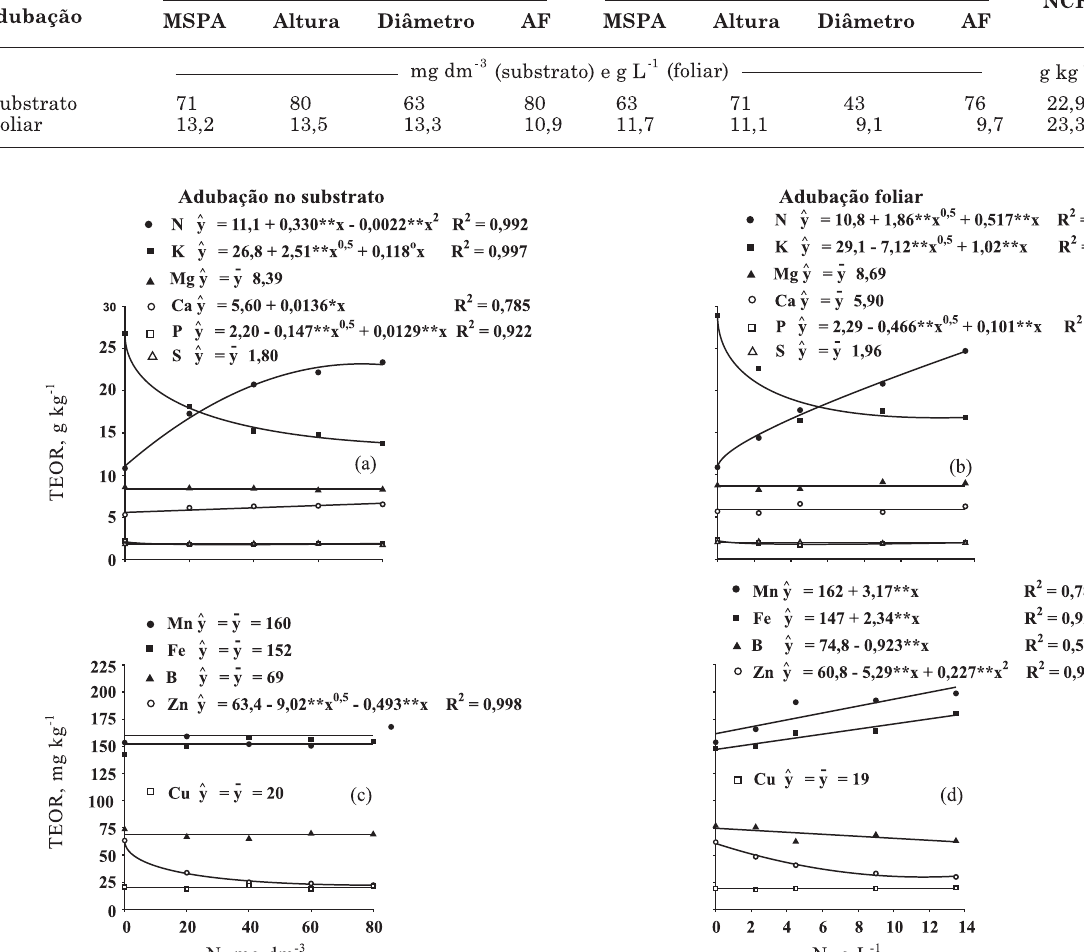
Figura 2. Teor de macro e micronutrientes na folha diagnóstica de mudas de cacaueiro, aos 145 dias, em função da dose de nitrogênio e forma de adubação: no substrato ou foliar. **, * e o , significativo a 1, 5 e 10 % pelo teste F,